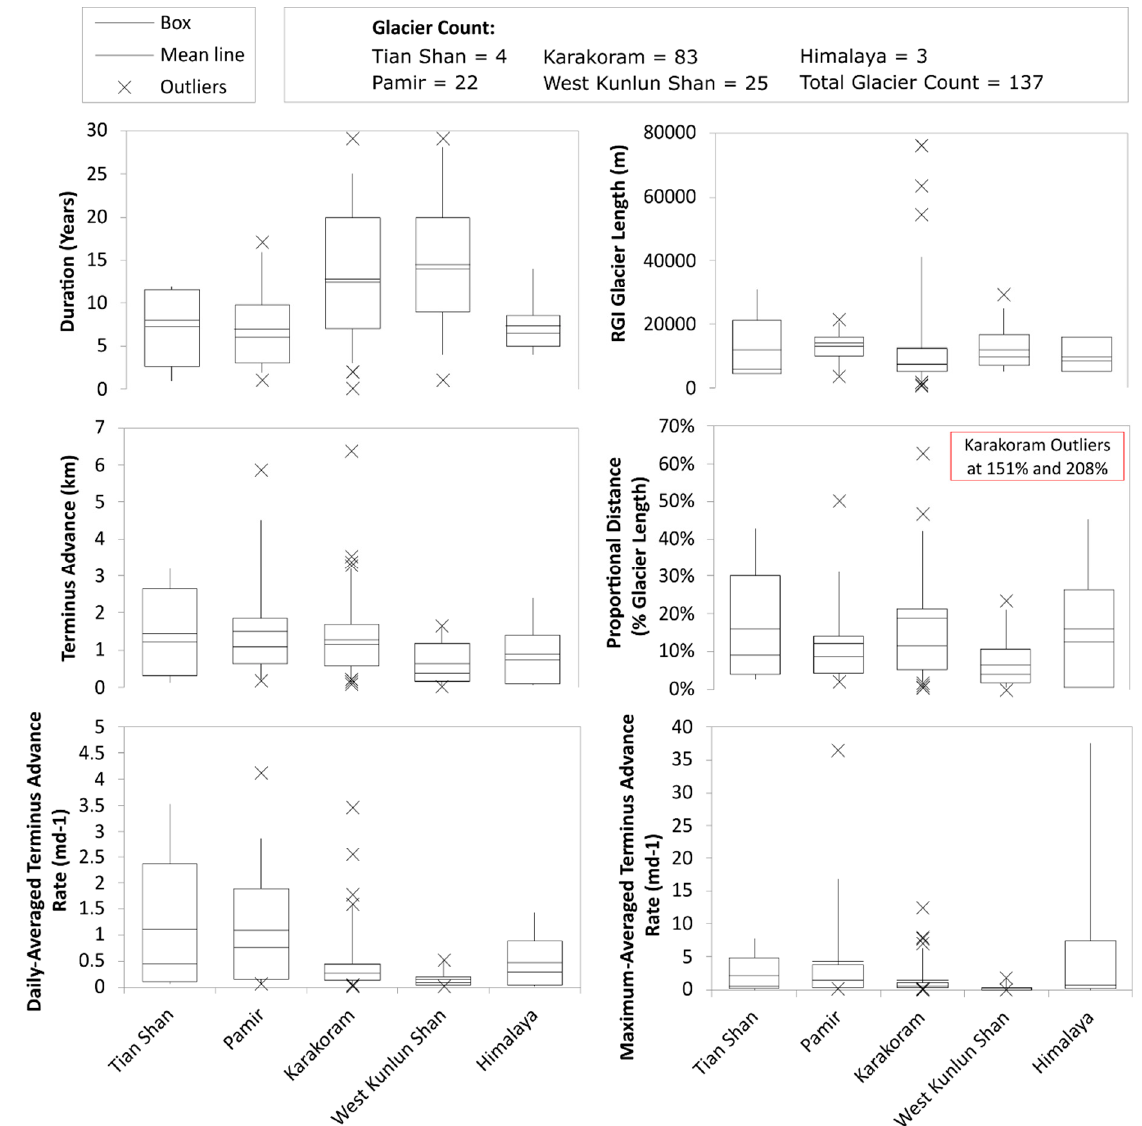
Figure 7. Boxplots showing surge variables at the sub-regional scale: surge duration ( top left ), RGI v6.0 glacier length ( top right ), surge terminus advance distance ( middle left ), surge proportional distance ( middle right ), daily averaged and maximum-averaged terminus advance rate ( bottom left and right ).